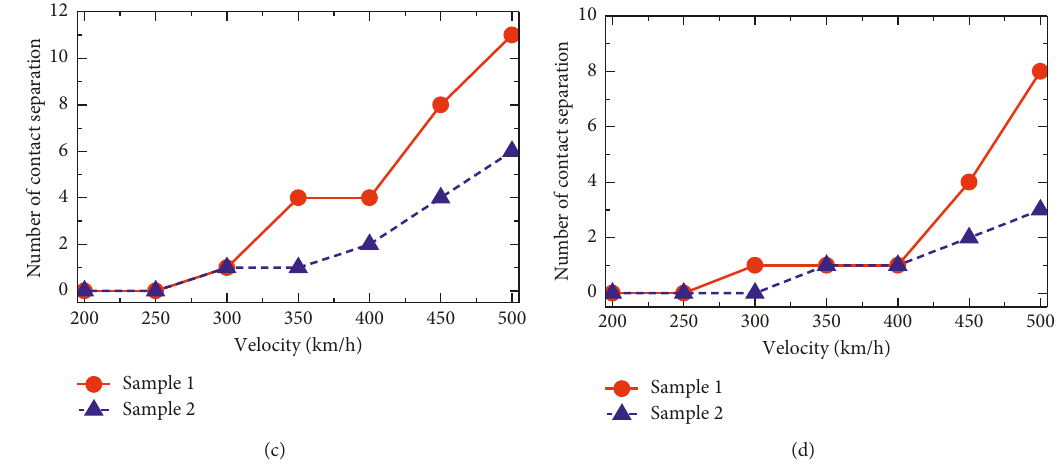
Figure 9: Number of contact separations in the presence of random track irregularities: (a) 1 st wheelset; (b) 2 nd wheelset; (c) 3 rd wheelset; (d) 4 th